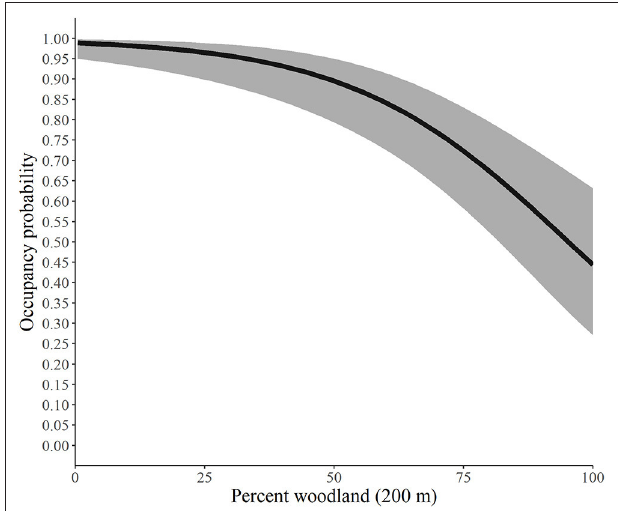
FIGURE 2 | Predicted probability of site occupancy by monarchs as a function of the percent of the landscape in woodland at the 200-m spatial scale, Iowa, 2006-2017. The solid line represents the predicted probabilities and the gray region is the 95% confidence envelope. Predictions are based on the model